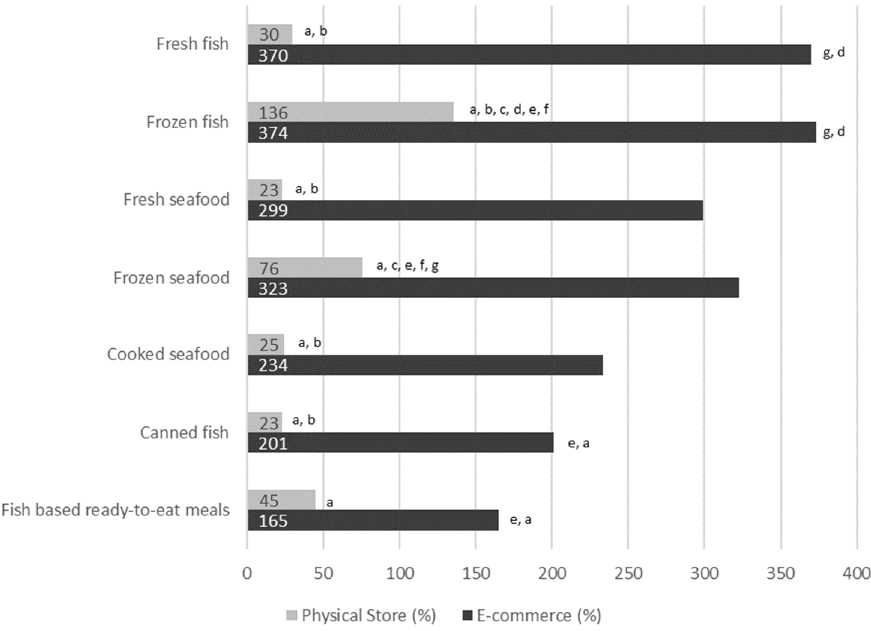
Figure 5. Relative increment in purchases of fish, seafood, and fish products in Spain from 2019 to 2020, during the period March to June, according to fish product and type of retailing. In all cases differences between e-commerce and physical store are statistically significant ( p < 0.005); Compara- tive between type of fish products within same group (E-commerce or Physical store); a, Significant differences ( p < 0.005) compared to frozen fish; b, Significant differences ( p < 0.005) compared to frozen seafood; c, Significant differences ( p < 0.005) compared to cooked seafood; d, Significant differences ( p < 0.005) compared to fish based ready-to-eat meals; e, Significant differences ( p < 0.005) compared to fresh fish; f, Significant differences ( p < 0.005) compared to fresh seafood; g, Significant differences ( p < 0.005) compared to canned